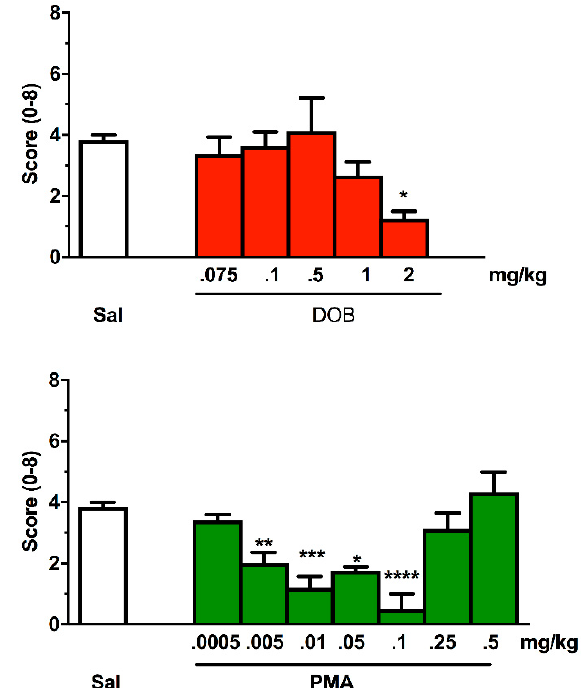
Figure 6. Effect of increasing doses of DOB and PMA on the appearance of trance-like effect evaluated for 5 min after treatment. Each compound was given i.m. immediately before the test. n = 10 for each group. Data were expressed as score ( ± SEM). * p < 0.05, ** p < 0.01, *** p < 0.001, compared with the corresponding saline group (Sal) (Kruskal–Wallis, Dunn’s test).